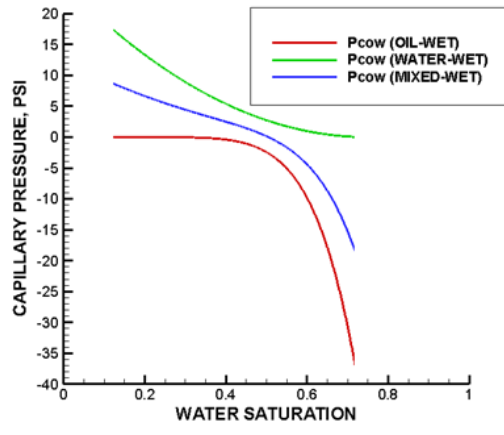
Figure 5: Capillary pressure curves for different wettability condi-